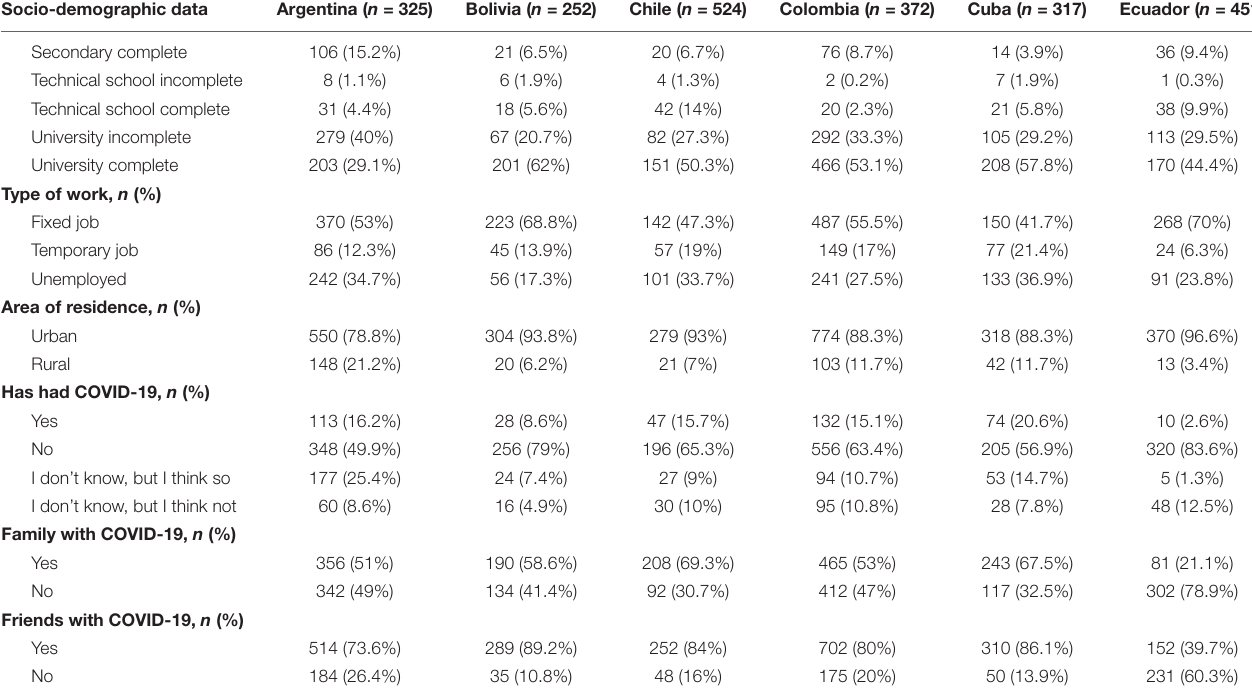
TABLE 2 | Original English version of the PCIBS and the translation into Spanish. Items from the original English version Translation of the Items in the Spanish